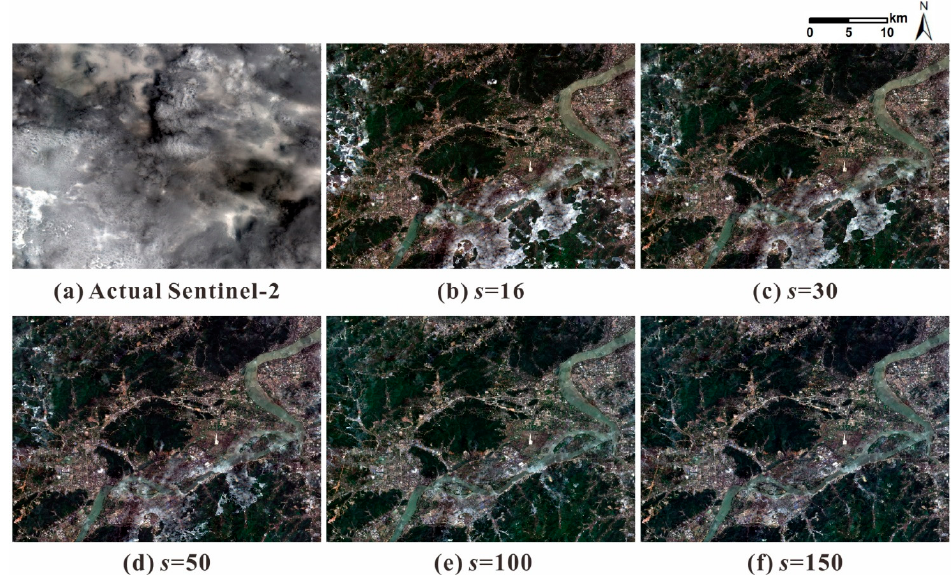
Figure 14. The actually acquired Sentinel-2 image ( a ) in Case 3 situation in Area B (22 June 2020), and reconstructed images ( b – f ) with different values of 𝑠 .